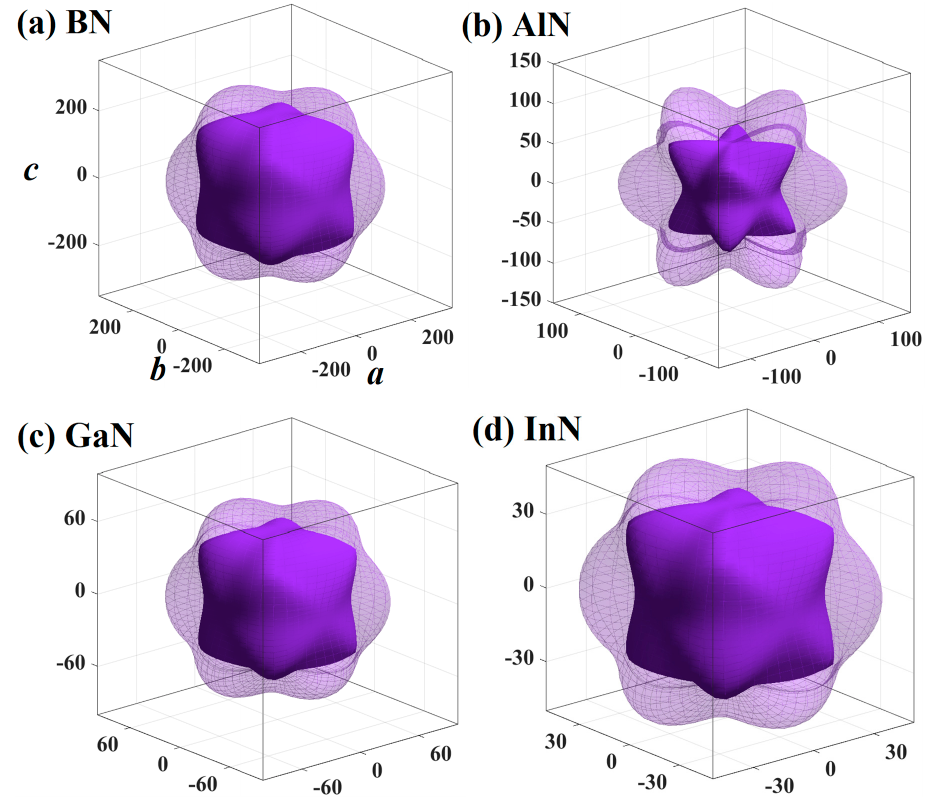
Figure 6. The 3D silhouette maps of the G for BN ( a ), AlN ( b ), GaN ( c ), and InN ( d ) in the Pm −3 n phase.